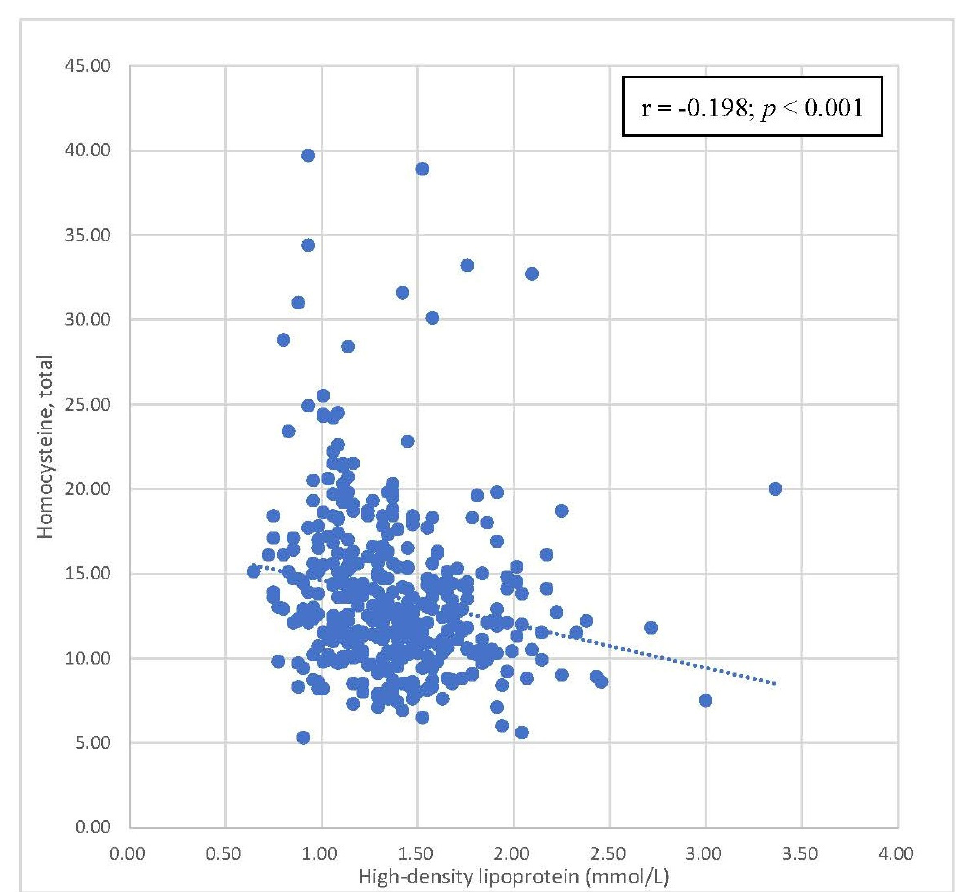
Figure 5. Scatterplot with the fit line of homocysteine levels by high-density lipoprotein.